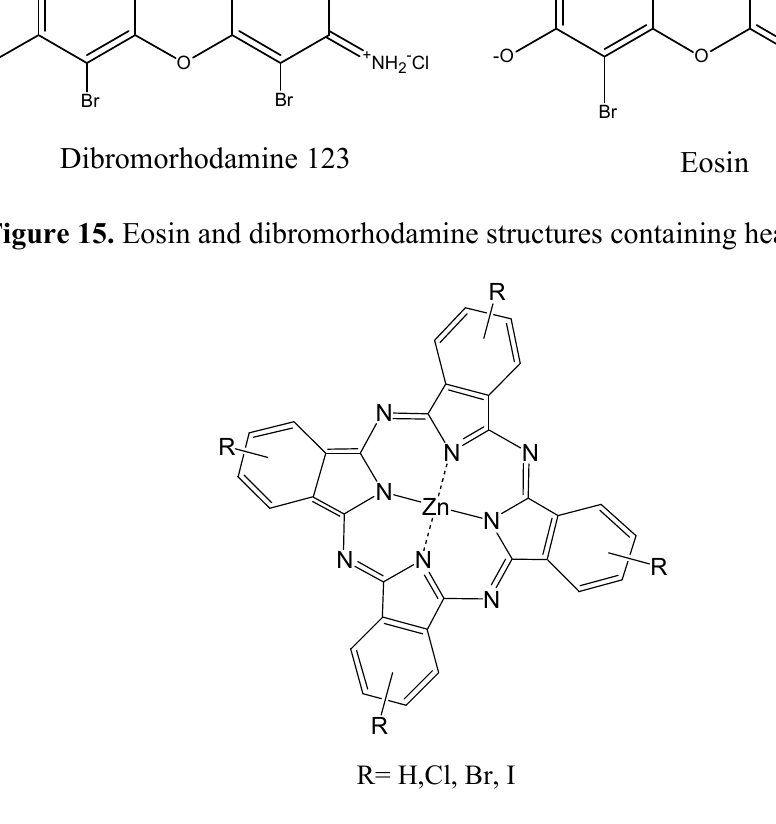
Figure 16. Halogenated Zn-Pc structures for enhanced 1 O 2 formation